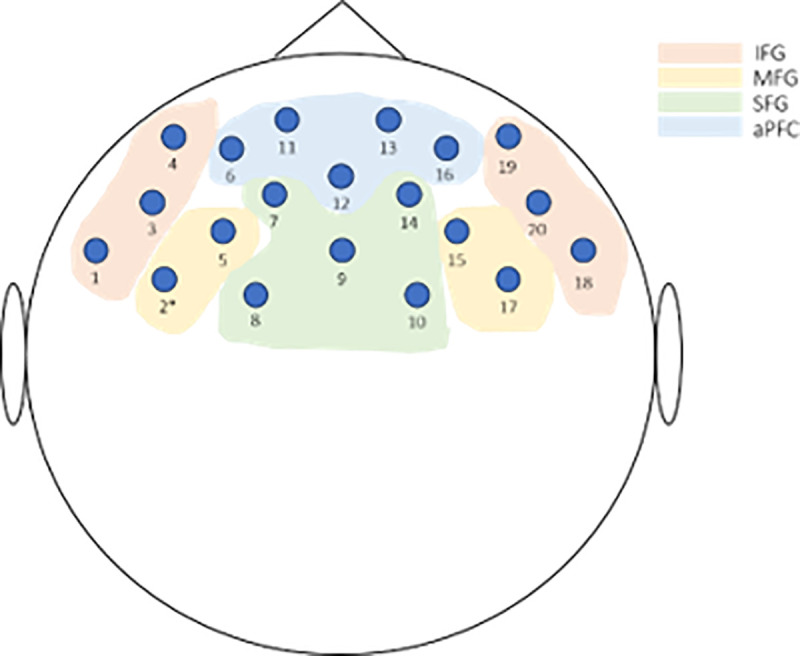
Diagram displaying channel locations and corresponding positions in the inferior frontal gyrus (IFG), middle frontal gyrus (MFG), superior frontal gyrus (SFG), and anterior PFC (aPFC).Montage for probe placement is based on the 10–20 system.